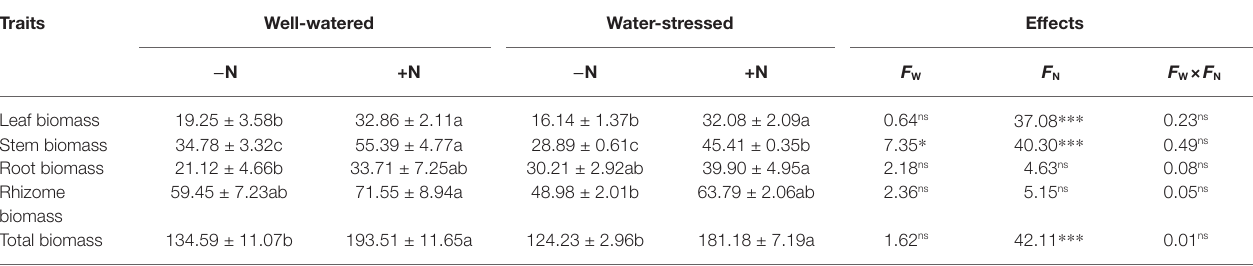
TABLE 1 | Biomass of Fargesia denudata plants under N non-deposition ( − N) and N deposition (+N) treatments with and without drought stress. Traits Well-watered Water-stressed